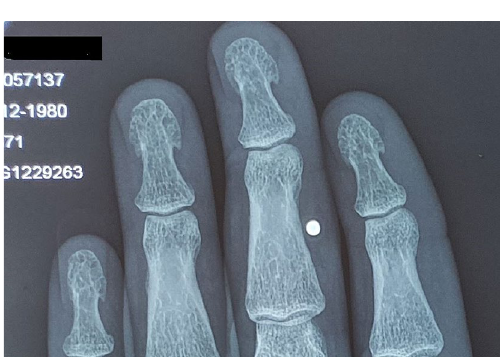
Figure 4. Zoom of previous Plain X ray hands PA view shows tuft spur-like excrescences mimicking that of (spade phalanx sign) of